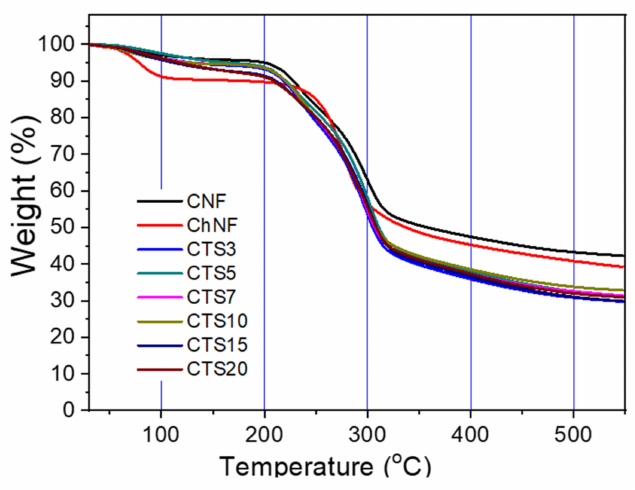
Figure 9. TGA of ChNF–CNF